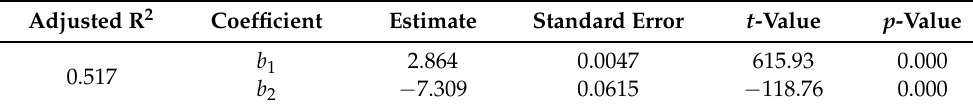
Table D2. Model 2 estimated coefficients by linear regression.